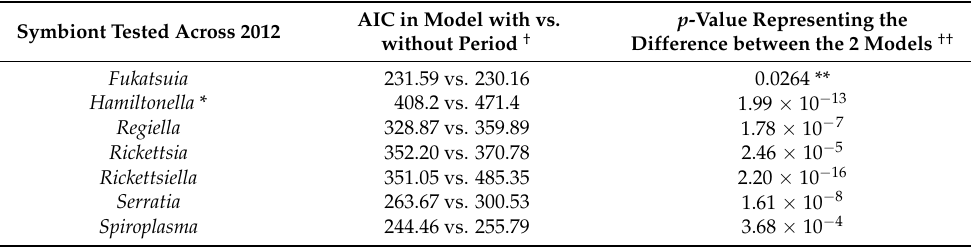
Table 1. Generalized linear mixed models statistics assessing whether seven facultative symbionts changed in frequency over time (a.k.a. “period”) across the 2012 field